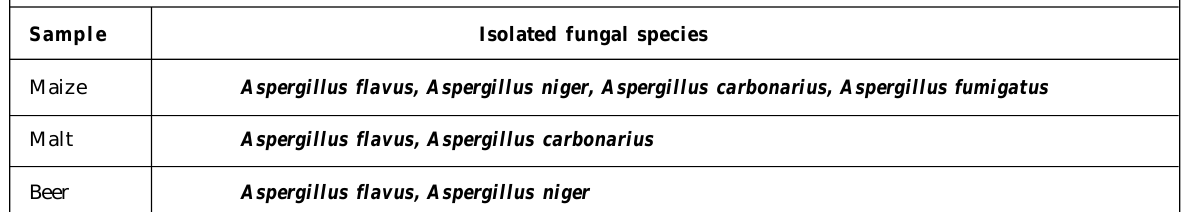
Table 3: Identified fungi in maize, malt and beer